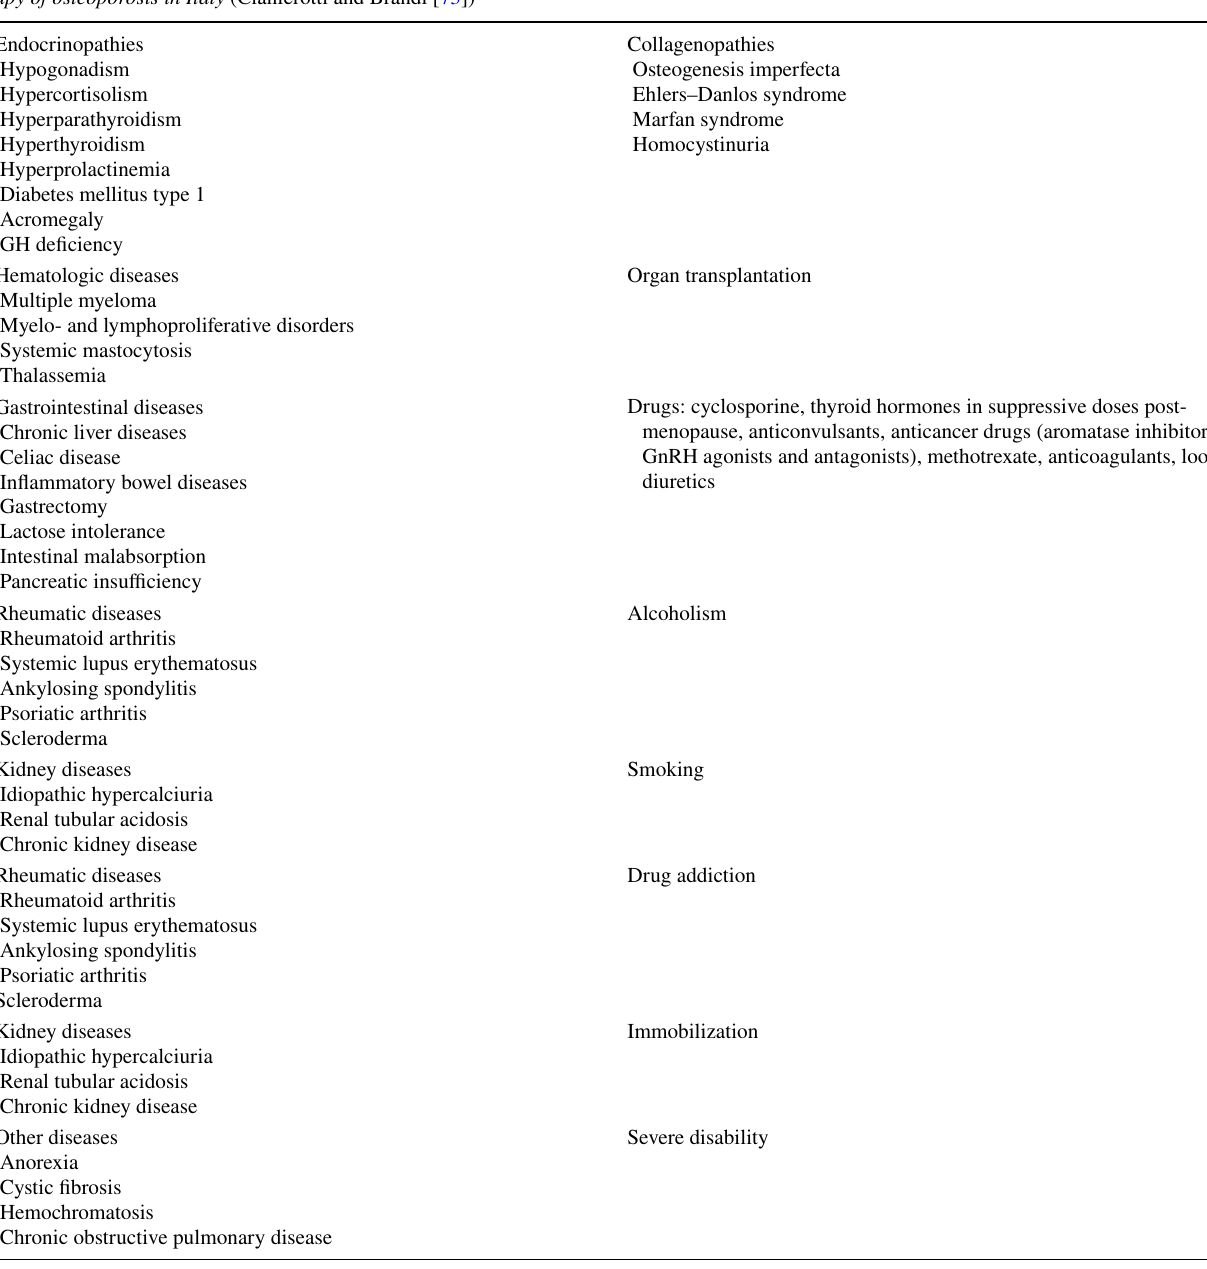
Table 2 Secondary causes of osteoporosis. Reproduced (with permission) from Table 7 of the Guidance for the diagnosis, prevention and ther‑ apy of osteoporosis in Italy (Cianferotti and Brandi [73]) Endocrinopathies